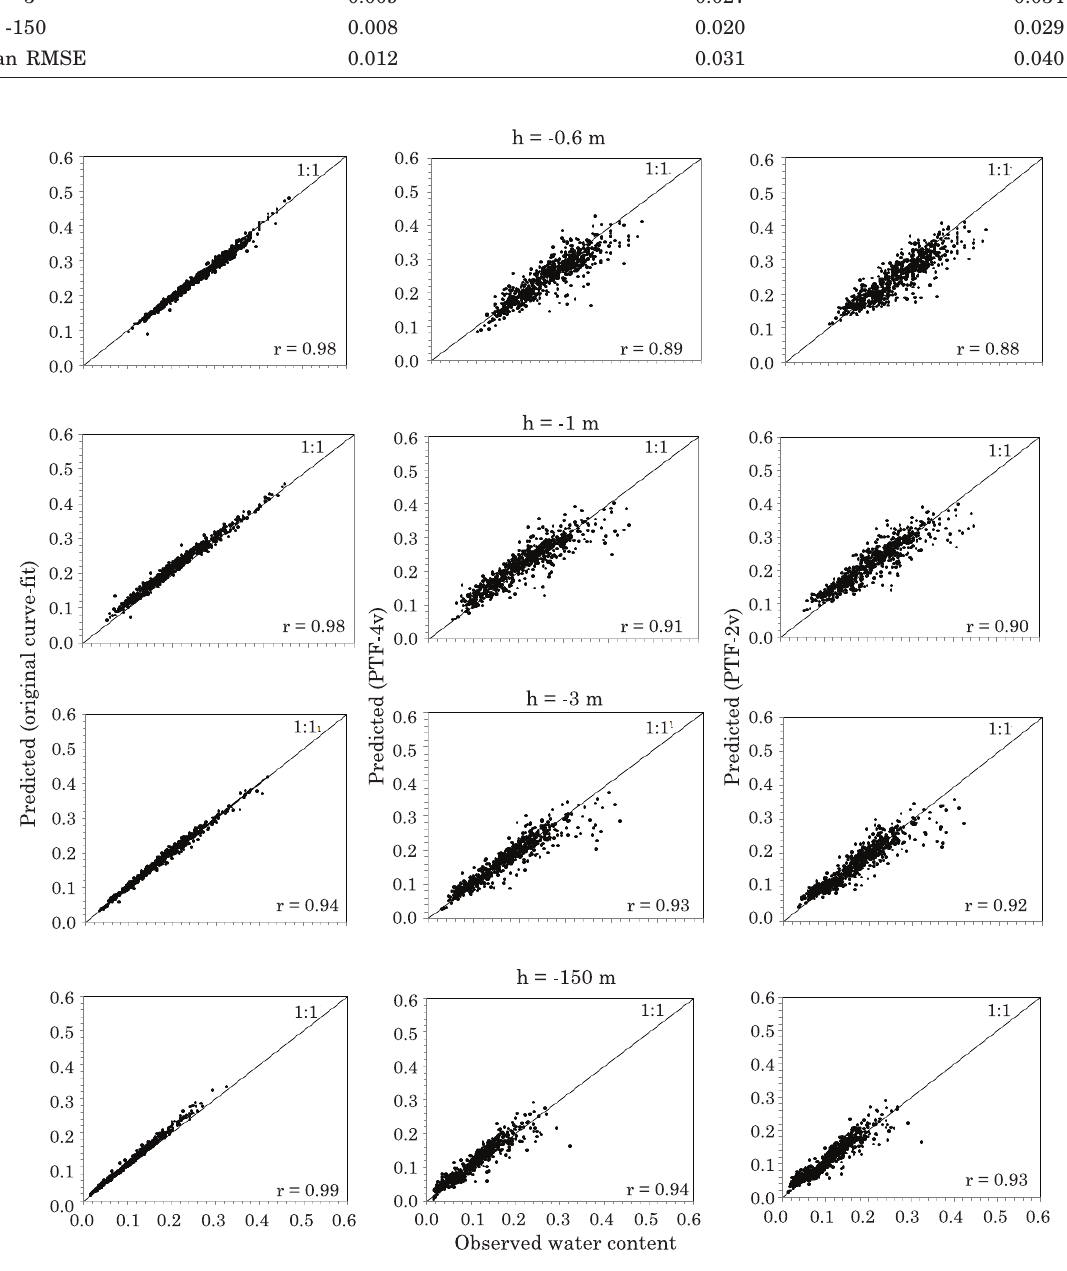
Figure 6. Observed water contents (m 3 m -3 ) at four specific pressure heads versus respective water contents predicted by the original fitted van Genuchten (VG) model (Equation 2) (left column), with VG parameters predicted by PTF- 4v (middle column) and by PTF- 2v (right column) for the development subset (internal